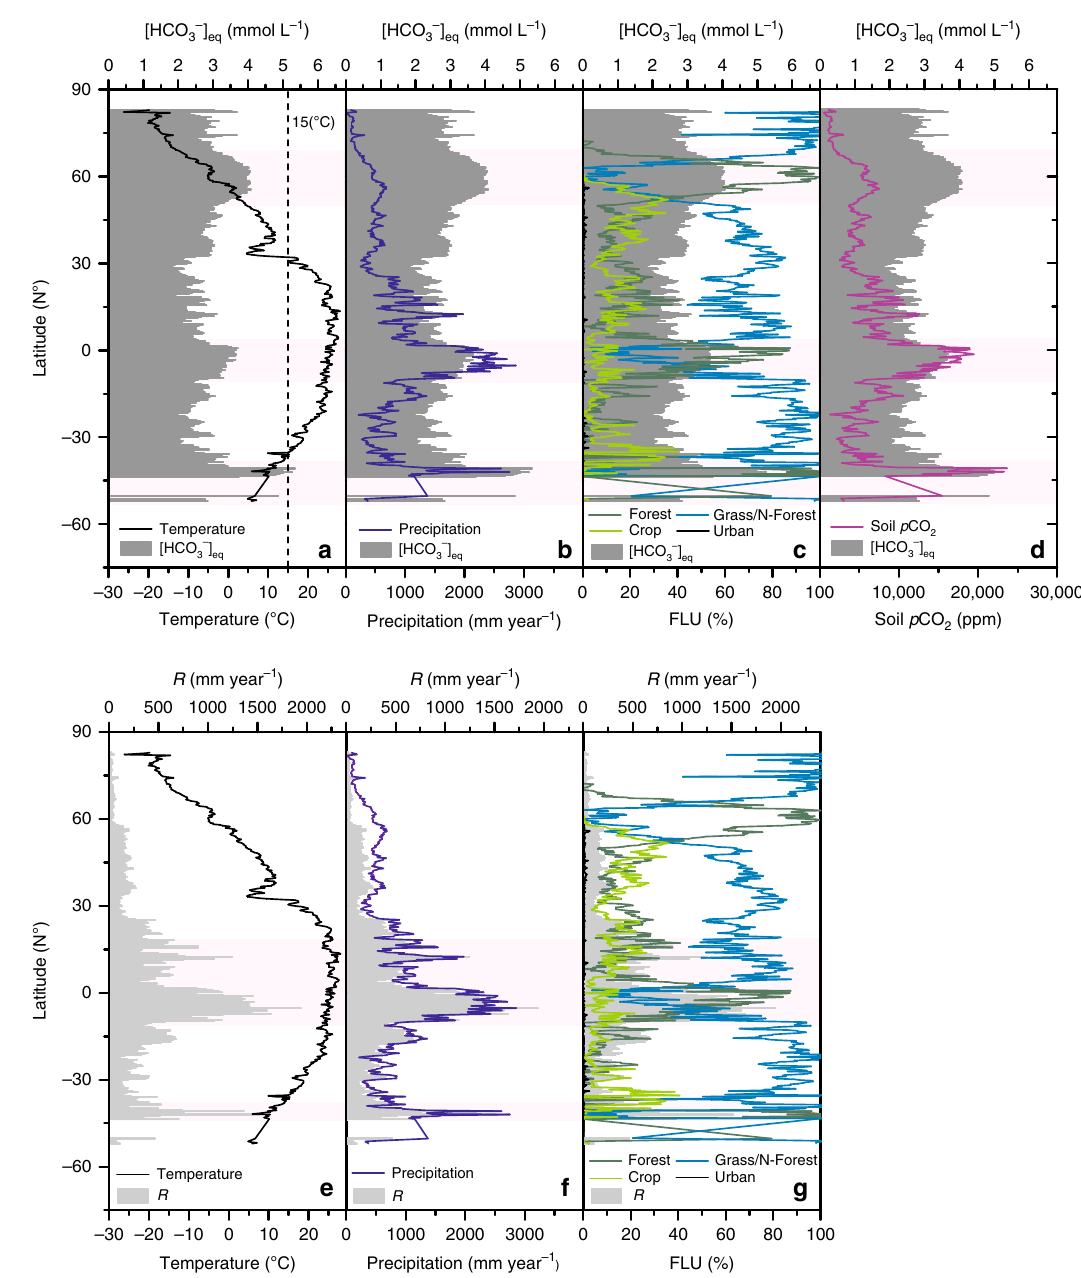
Fig. 4 Latitudinal variations of relevant variables. [HCO 3 − ] eq (dark-shaded area in a – d ) and R (runoff, light-shaded area in e – g ) in relation with mean temperature (black line in a and e ), mean precipitation (blue line in b and f ), land-use type (multicolor lines in c and g ), and soil p CO 2 (purple lines in d ) in the historical period (1950 – 2005). Three [HCO 3 − ] eq peaks occur in three latitudinal zones (50 – 70 °N, 0 – 10 °S, and 40 – 50 S°). The dashed line in a is the upper temperature limit (15 °C) for maximum carbonate dissolution. The highest runoff ( R ) can be found in the tropical zone and the area close to 40